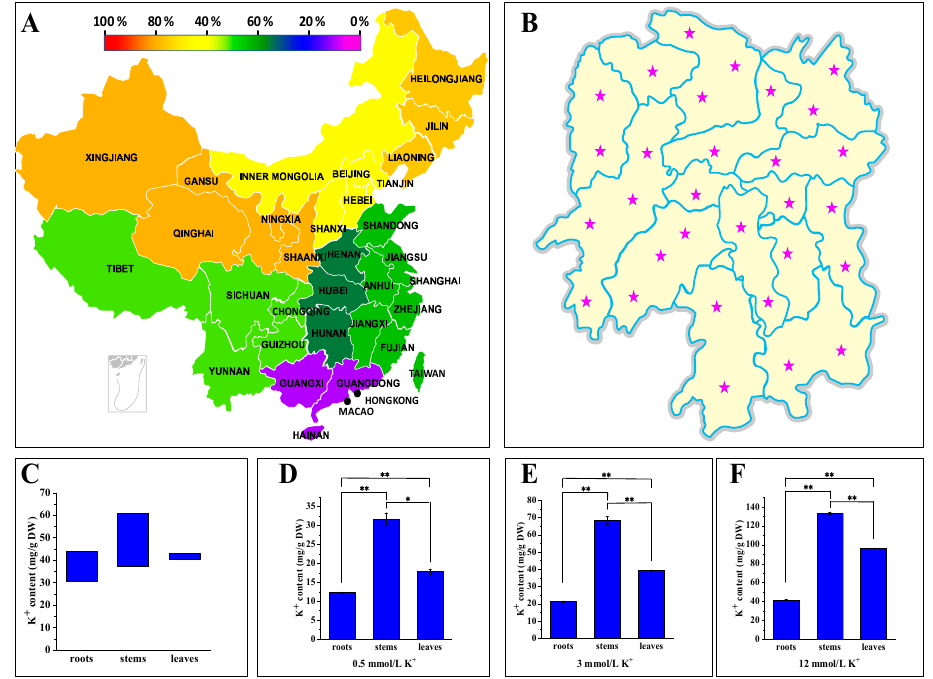
Figure 1. ( A ) The area percentage of available potassium (> 100 mg/ kg) in fields in the main regions of China; ( B ) Sample collection sites in Hunan Province; ( C ) Content ranges of potassium in different tissues of Phytolacca acinosa collected from fields; ( D – F ) Potassium accumulation in different tissues of P. acinosa under different K + treatments. Data shown as means ± SD of three biological replicates ( n = 30). Asterisks indicate a significant difference based on a Dunnett’s test. * significant difference at 5% level ( P < 0.05); ** significant difference at 1% level ( P < 0.01).